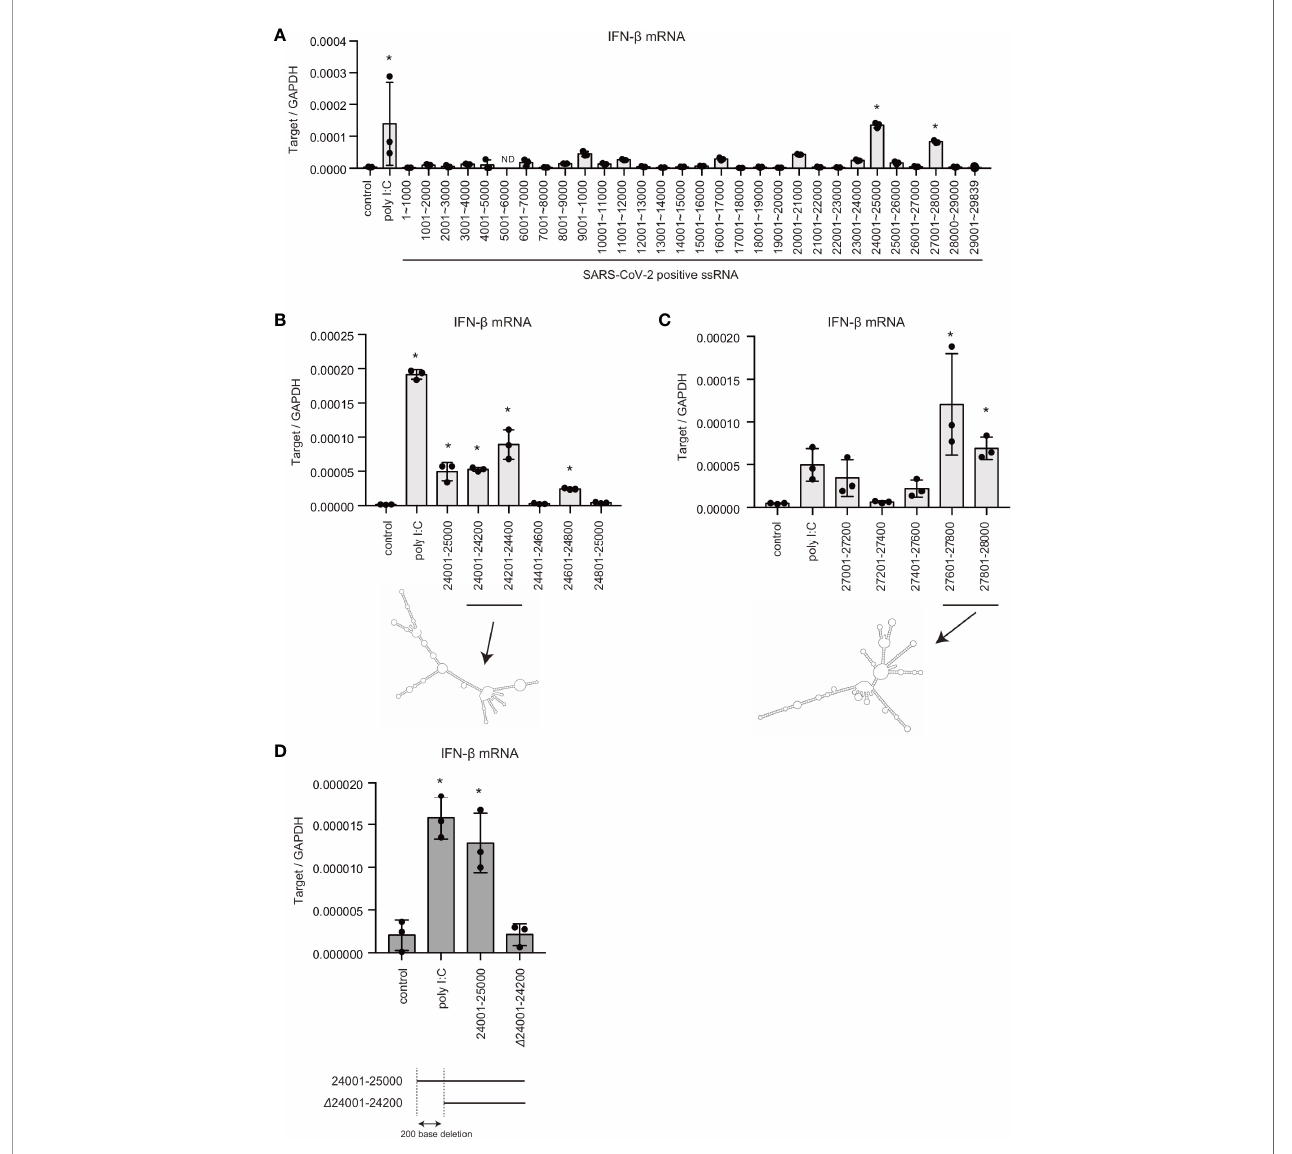
FIGURE 2 | Viral genomic RNA regions that induce type I IFN expression. (A) SARS-CoV-2 viral RNA fragments were synthesized in vitro with T7 RNA polymerase. Each viral RNA fragment or short poly I:C was transfected into HEK293 cells for 6 h, and type I IFN expression was determined by RT-qPCR. The data represent the mean ± SD (n = 3, *p < 0.05, One-way ANOVA)). The data shown is representative of two independent experiments. (B, C) Short poly I:C or viral RNA fragments containing depicted viral RNA regions were transfected into HEK293 cells, and type I IFN expression was determined by RT-qPCR. The data represent the mean ± SD (n = 3, *p < 0.05, One-way ANOVA)). Predicted secondary structures of viral RNA 24001 – 24400 and 27601 – 28000 are shown in lower panel. The data shown is representative of two independent experiments. (D) Viral RNA fragments, 24001 – 25000 and 24200 – 25000 ( D 24001-24200), were transfected into HEK293 cells, and type I IFN expression was determined by RT-qPCR. The data represent the mean ± SD (n = 3, *p < 0.05, One-way ANOVA). The data shown is representative of at least two independent